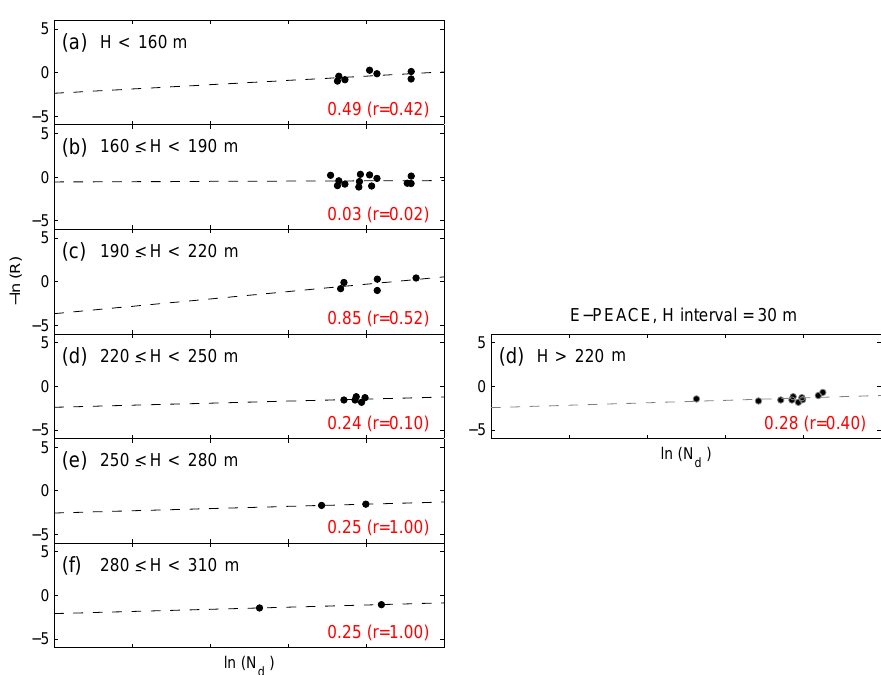
Figure C3. The ln ( N d ) and − ln ( R ) diagrams with fixed H intervals ( (cid:49)H = 30m).